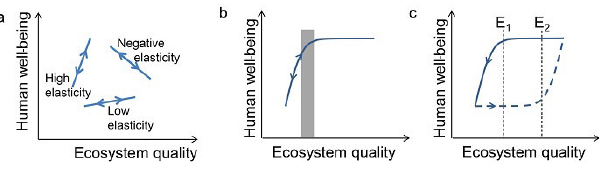
Fig. 1 . The ecosystem quality elasticity of human well-being (ES elasticity). (a) Examples of high, low, positive, and negative elasticities. (b) A threshold (shaded) in the ecosystem quality- well-being relationship leading to different elasticities at different levels of ecosystem quality. (c) Hysteresis in the ecosystem quality-well-being relationship such that elasticity is different when ecosystem quality is declining from when ecosystem quality is